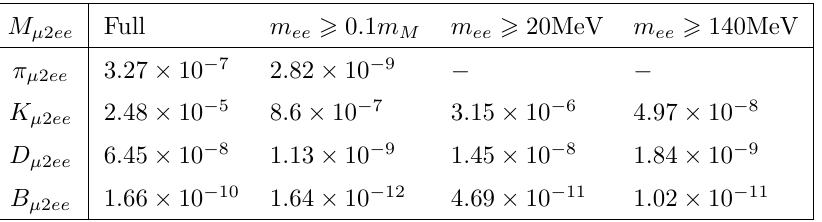
Table 1 . In the SM framework, a set of cuts in the di-lepton mass for the BR( M (cid:22) 2 ee ), used in the decay width calculations for IB contributions.